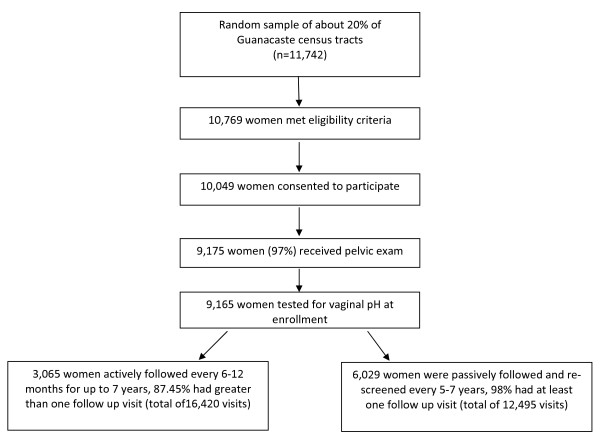
Consort diagram.